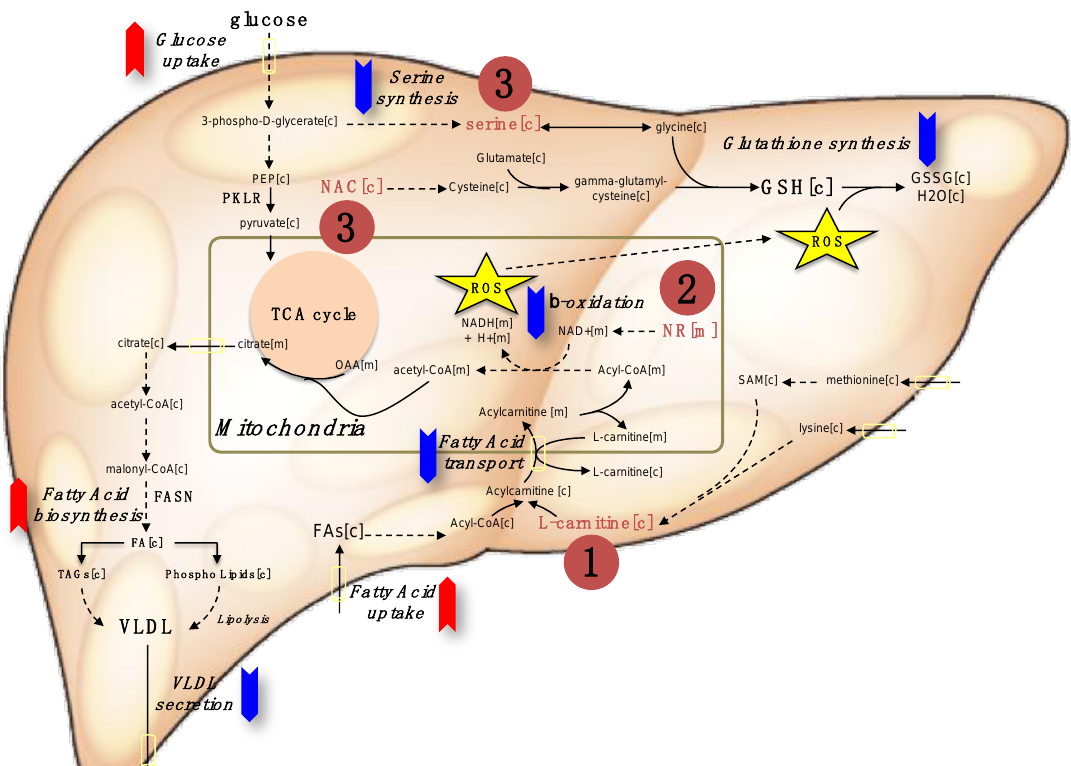
Figure 1. The red and blue arrows indicate the upregulation and down regulation of metabolic pathways in NAFLD, respectively. Metabolic cofactors can be supplemented to treat such metabolic abnormalities for effective treatment of the patients. The three-step strategy can be applied by supplementing (1) L -carnitine to enhance the transport of fatty acids across the mitochondrial membrane, (2) the NAD + precursor nicotinamide riboside to enhance the β-oxidation of fatty acids in mitochondria, and the (3) glutathione (GSH) precursors including serine and N -acetyl- L -cysteine (NAC) to form GSH that is required to protect liver against free radical-mediated oxidative stress generated by the increased β-oxidation of fatty acids in the mitochondria. TCA: The citric acid cycle, VLDL: Very-low-density lipoprotein, ROS: Reactive oxygen species. PKLR: pyruvate kinase L/R, FASN: Fatty acid synthase.